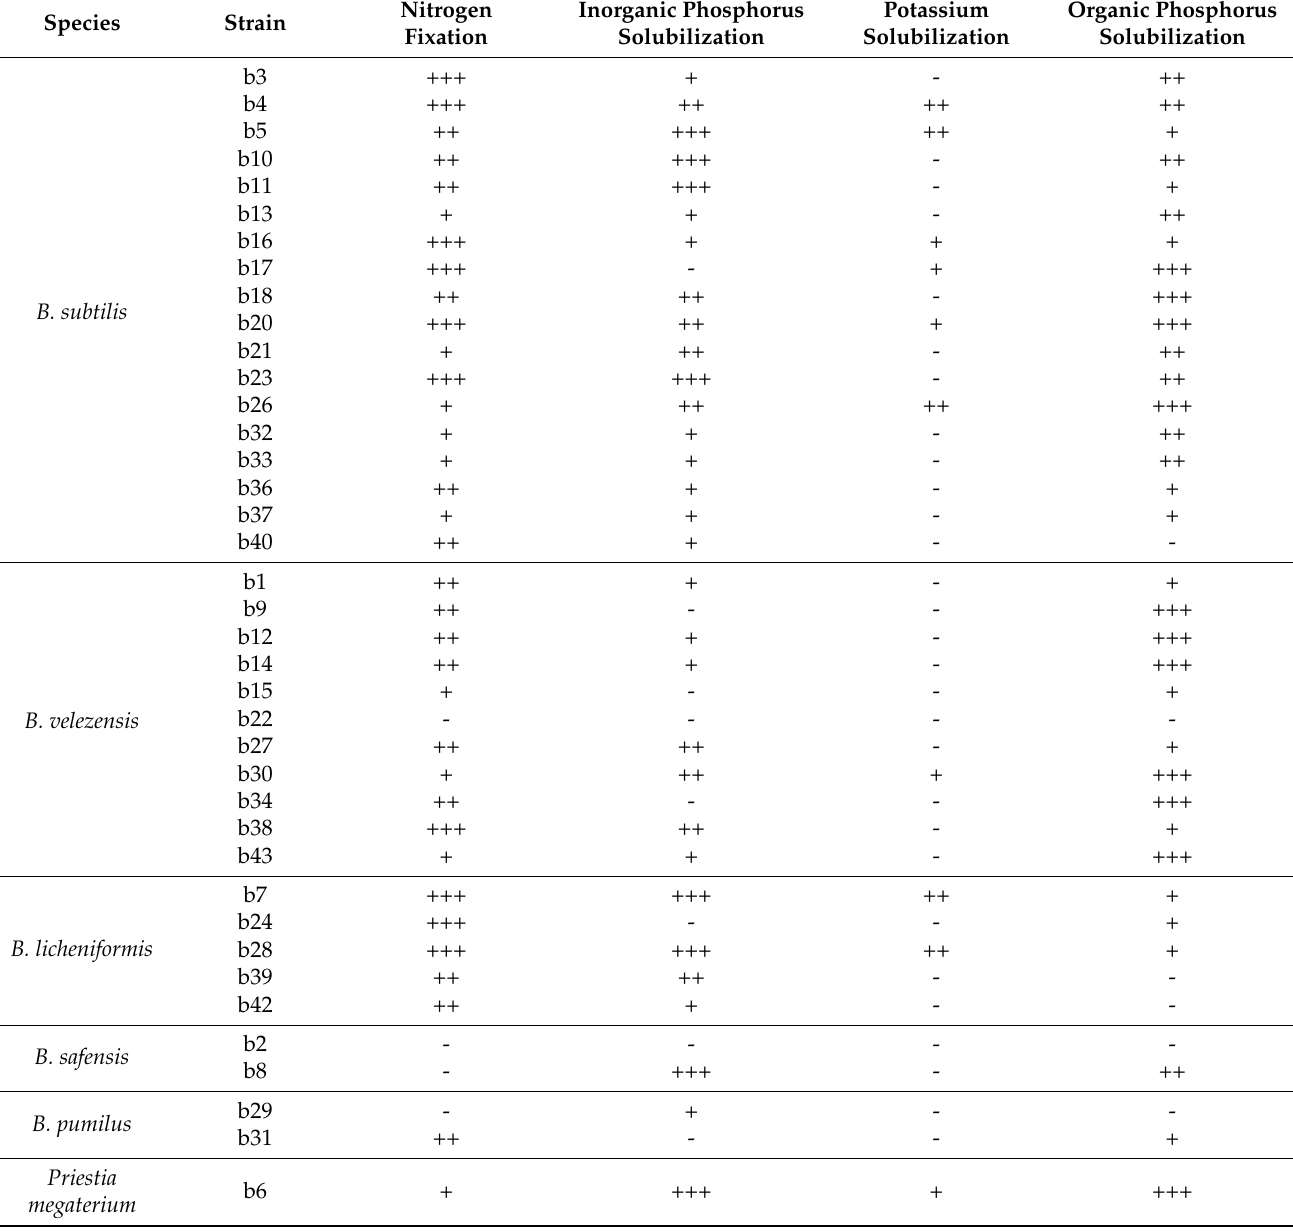
Table 5. Characters of endophytic bacteria on functional culture